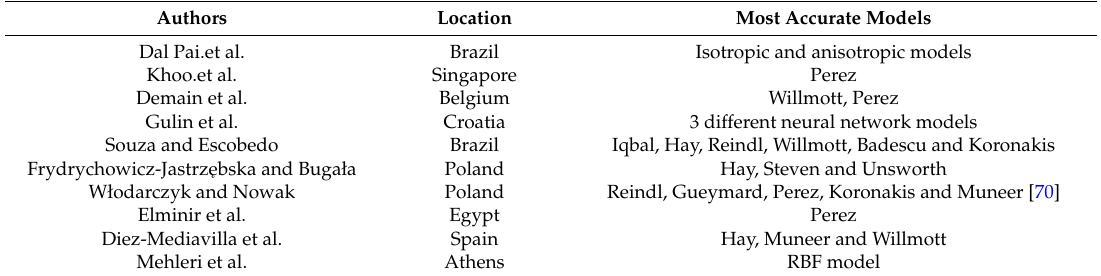
Table 7. Summary of studies on finding the most accurate diffuse models for inclined surfaces.